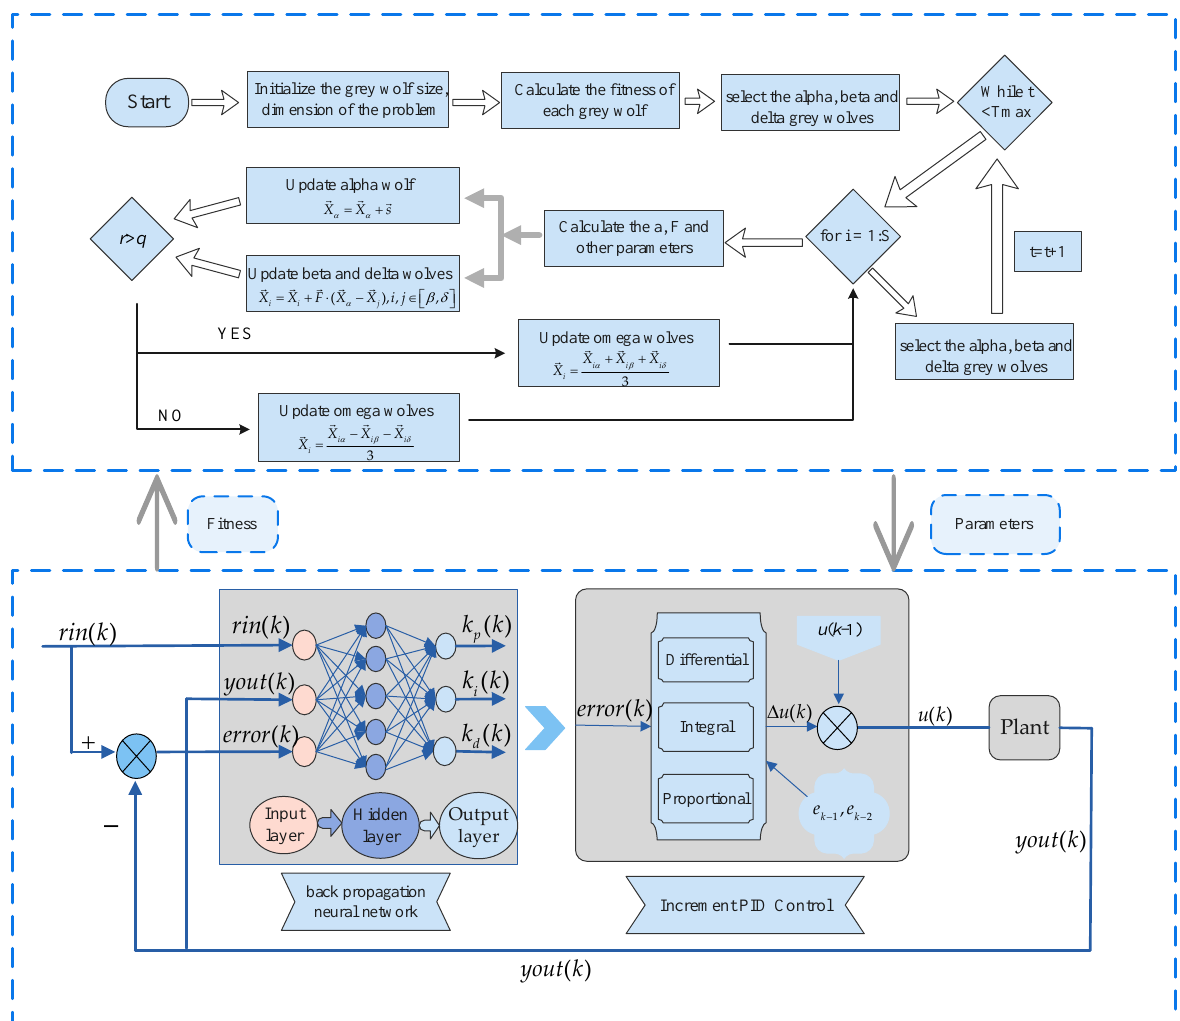
Figure 4. The process of total algorithm.